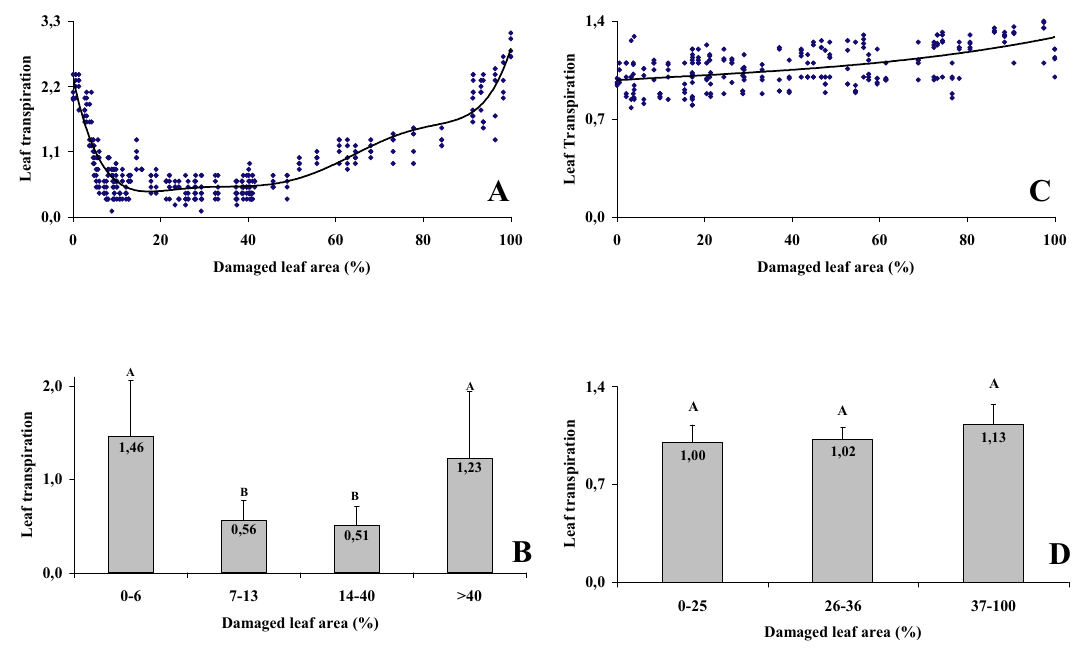
Fig. 5 – Effect of leaf area damaged (0 to 100%) by O. praelonga and L. coffeella on leaf transpiration (mmol H 2 Om − 2 s − 1 ) . Effect of O. praelonga infestation intensity at four intervals, on lime leaf transpiration (A and B) and of L. coffeella at three intervals, on Obatã coffee leaves (C and D). Treatments followed by the same letter do not differ by Tukey test, at 5%